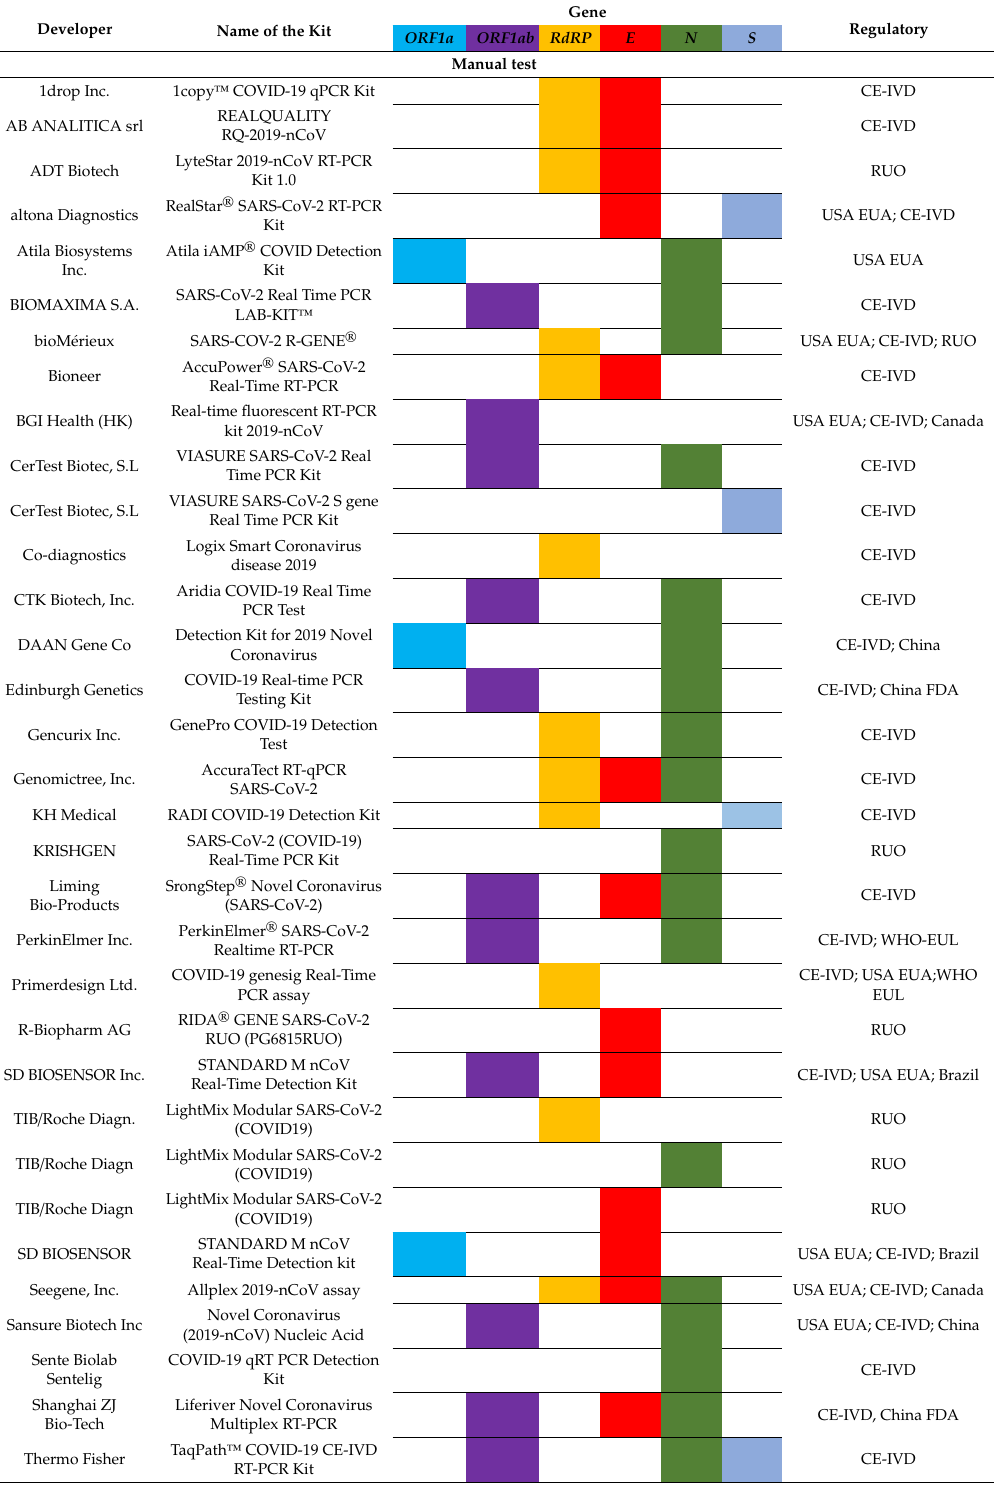
Table 1. Comparison of RT-qPCR dedicated for SARS-CoV-2 genes target points [12] (updated 13 June 2020, online